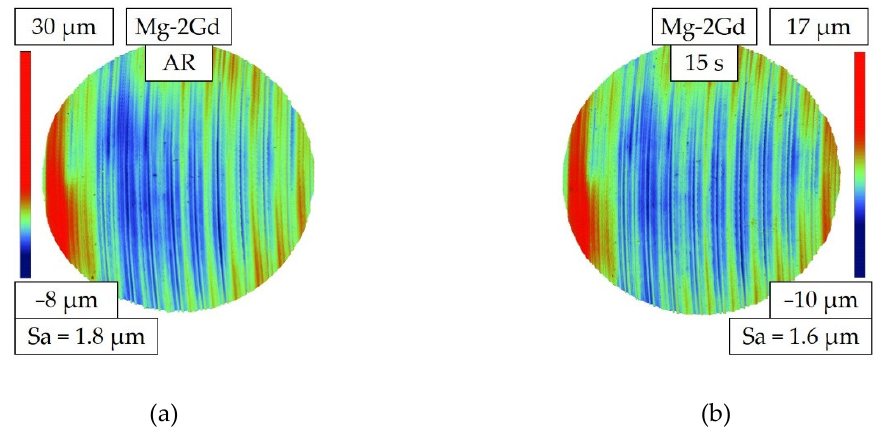
Figure 8. Topographies of the Mg-2Gd alloy as measured by white light interferometry (WLI): ( a ) Topography in as-received (AR) state with machining marks and a peak-valley difference of 38 (30 µ m to − 8 µ m) ( b ) Topography after etching with 250 g/L HAc for 15 s in 5 mL of solution. Machining marks are still visible and the peak-valley difference of 27 µ m (17 µ m to − 10 µ m) is reduced in as compared to the AR state.